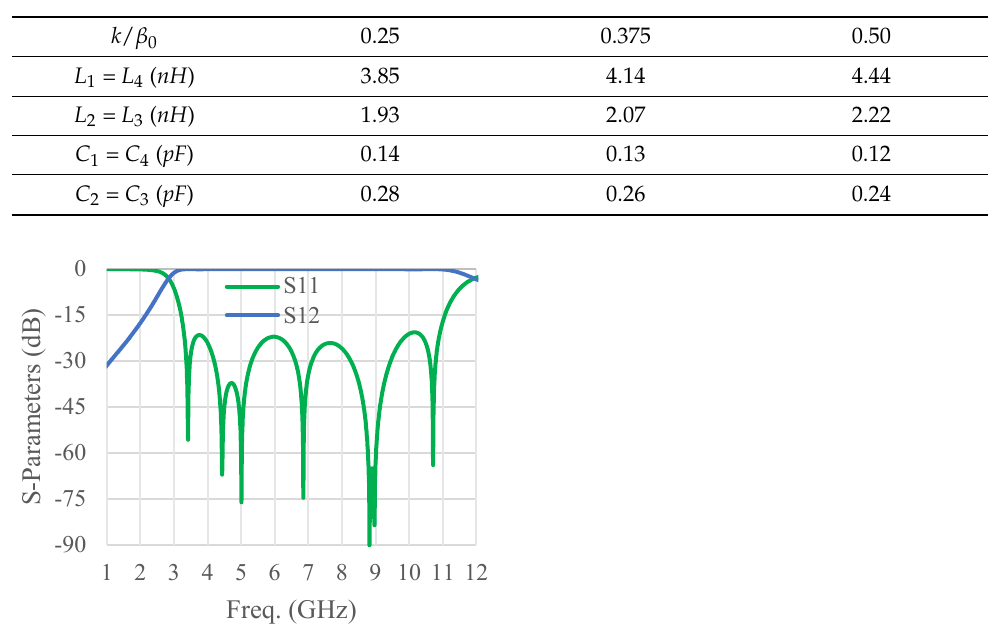
Figure 6. Layout of the proposed microstrip UWB bandpass filters with tapered resonators. Figure 7. UWB filter with LC equivalent resonators. Figure 7. UWB filter with LC equivalent resonators. Table 3. Equivalent lumped elements.